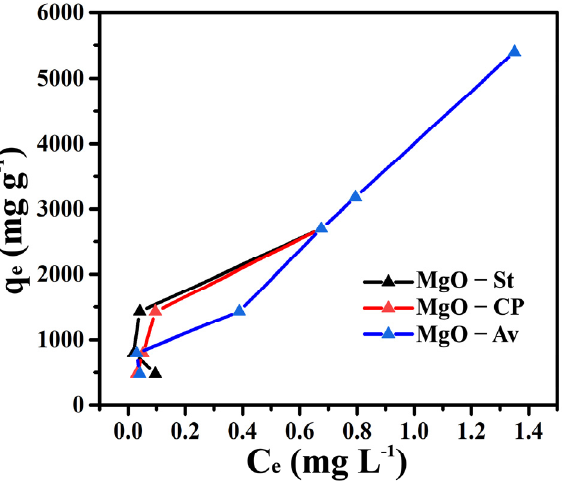
Figure 5. Experimental point curves for the adsorption of Cu 2+ ions onto MgO − St, MgO − Av, and MgO − CP at 298 K.